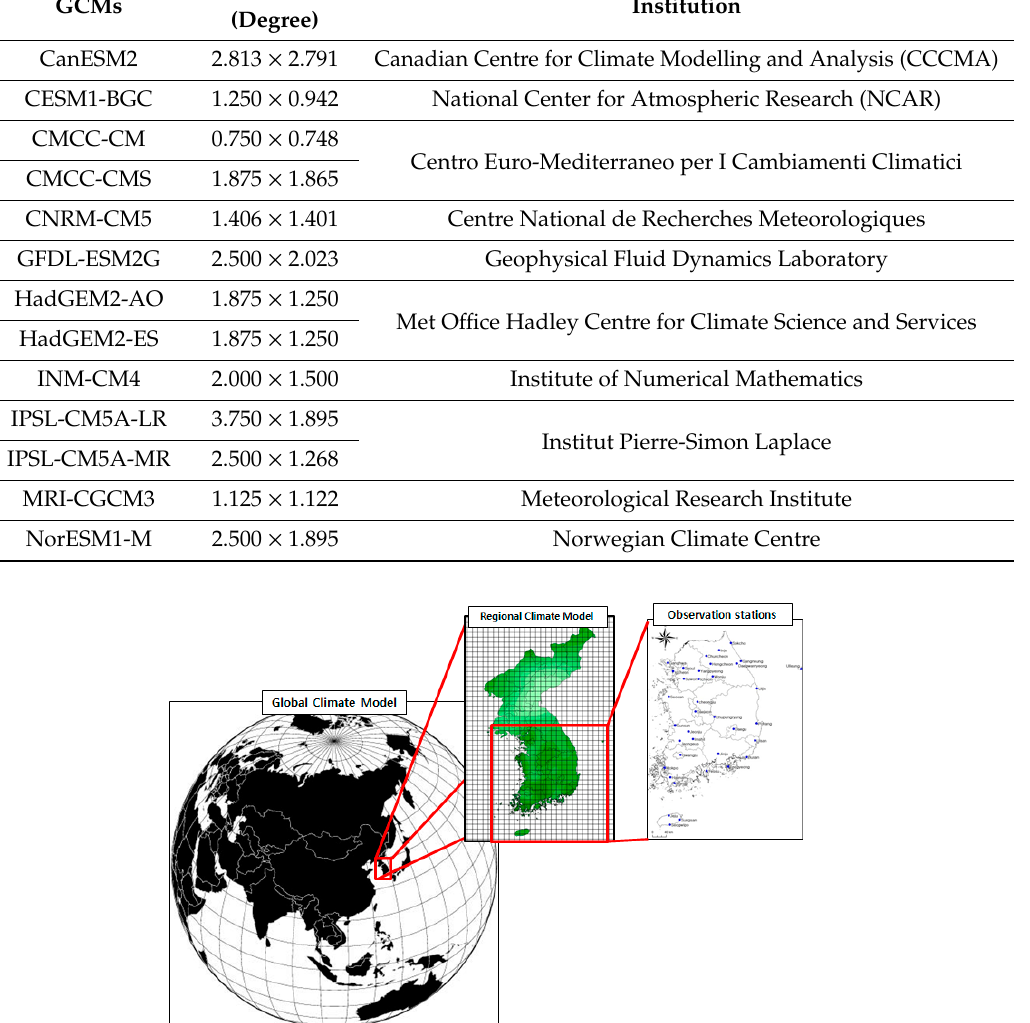
Table 1. Thirteen global climate models (GCMs) used for the study.